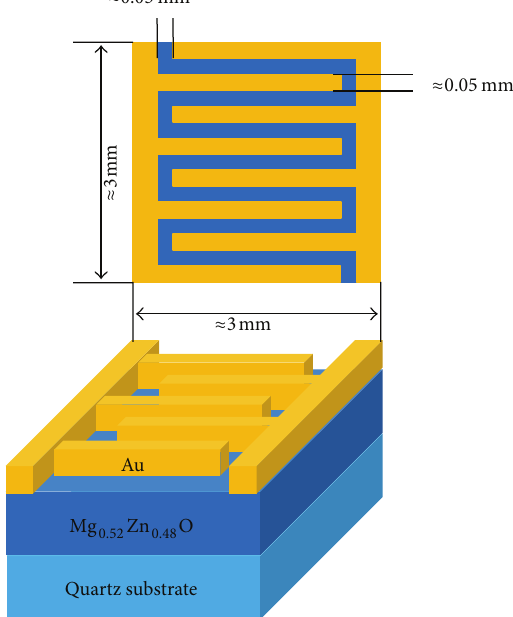
Figure 2: Schematic of the Mg 0.52 Zn 0.48 O